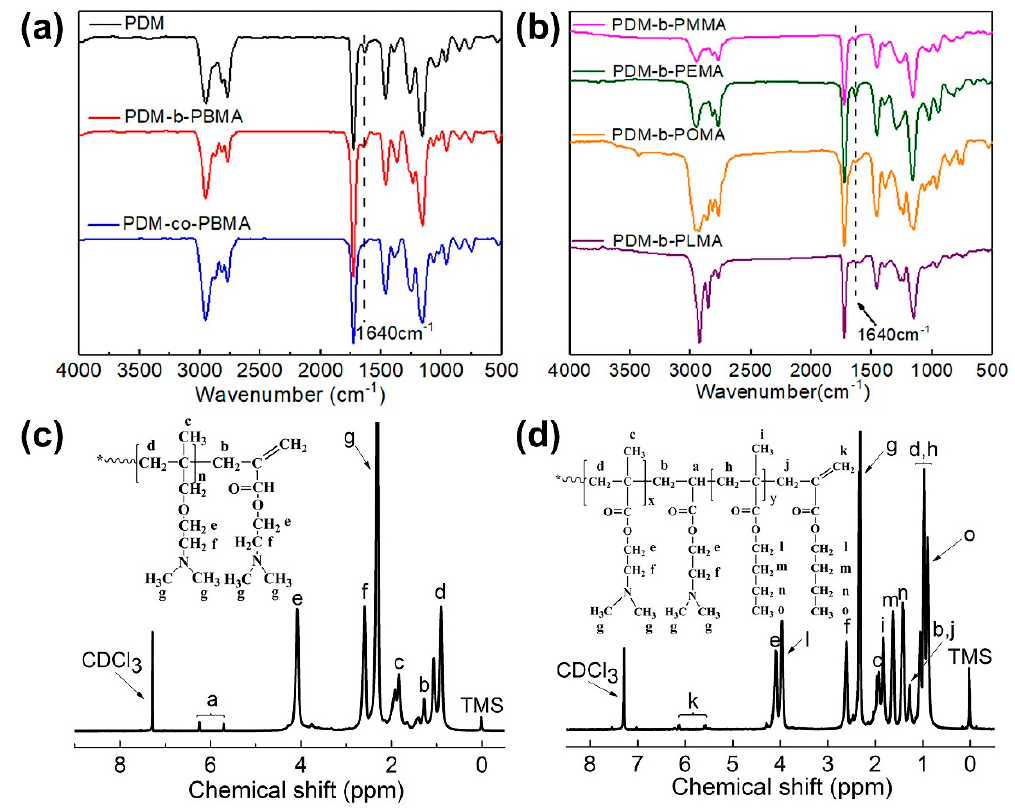
Figure 3. FTIR spectra of PDM, PDM- b -PBMA, PDM- co -PBMA ( a ) and PDM- b -PRMA ( b ), 1 H-NMR spectra of PDM ( c ) and PDM- b -PBMA ( d ).